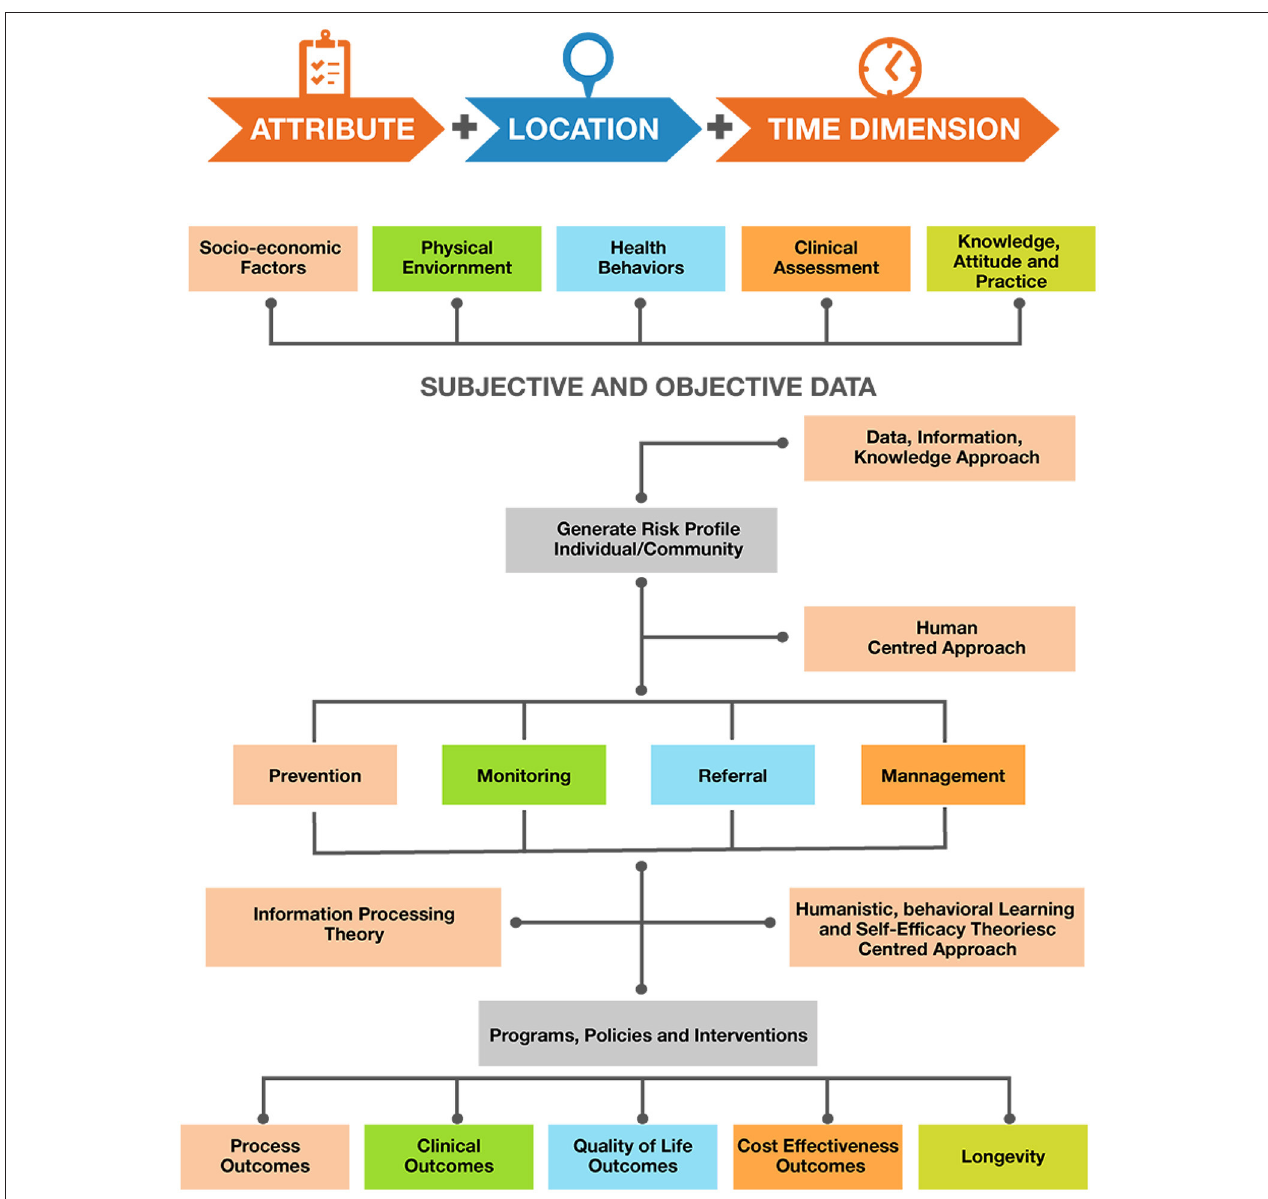
FIGURE 8 | Population Health Informatics Surveillance